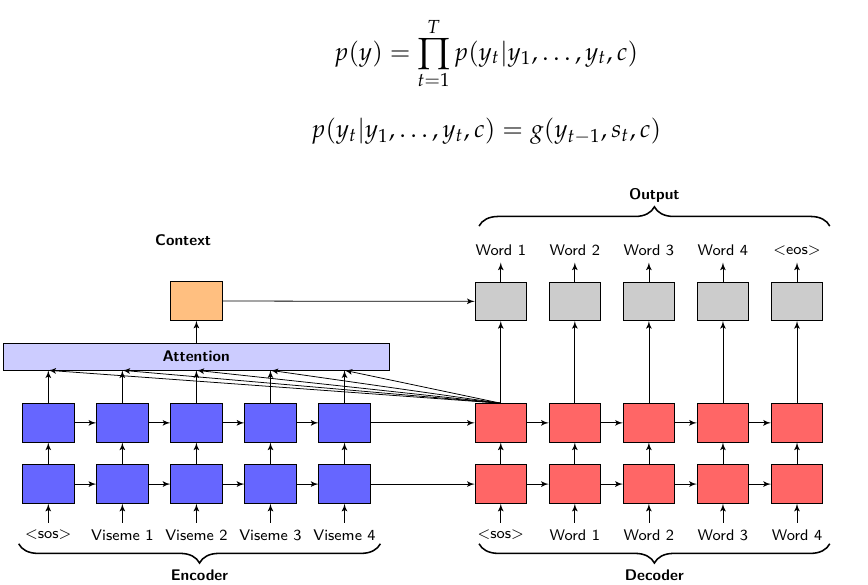
Figure 4. Components of Attention-based GRU architecture